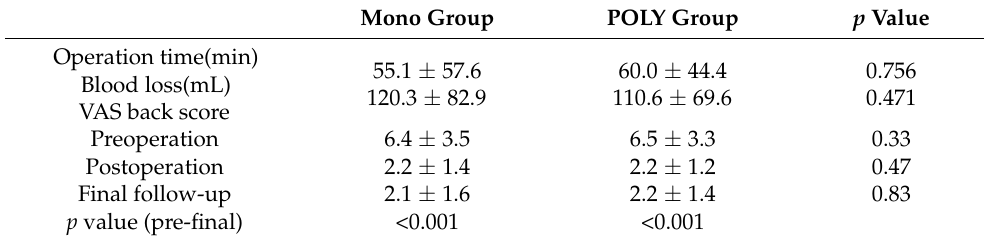
Table 3. Comparisons of clinical outcomes between the two groups.